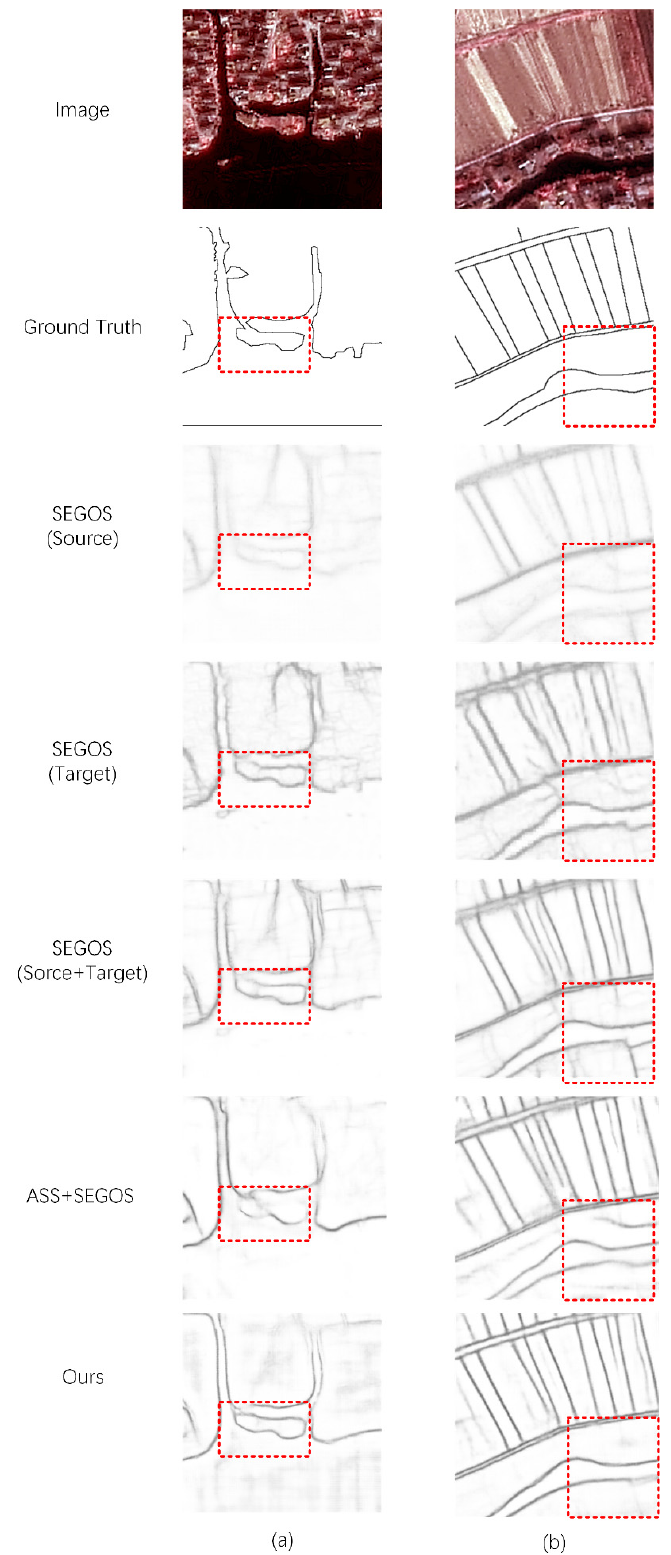
Figure 5. Comparison of the results of edge extraction methods. ( a , b ) are the results of different images. For each image, we show the results of SEGOS trained with the source domain dataset, SEGOS trained with the target domain dataset, SEGOS trained with a mixture of the two domain datasets, AAS, and our method.